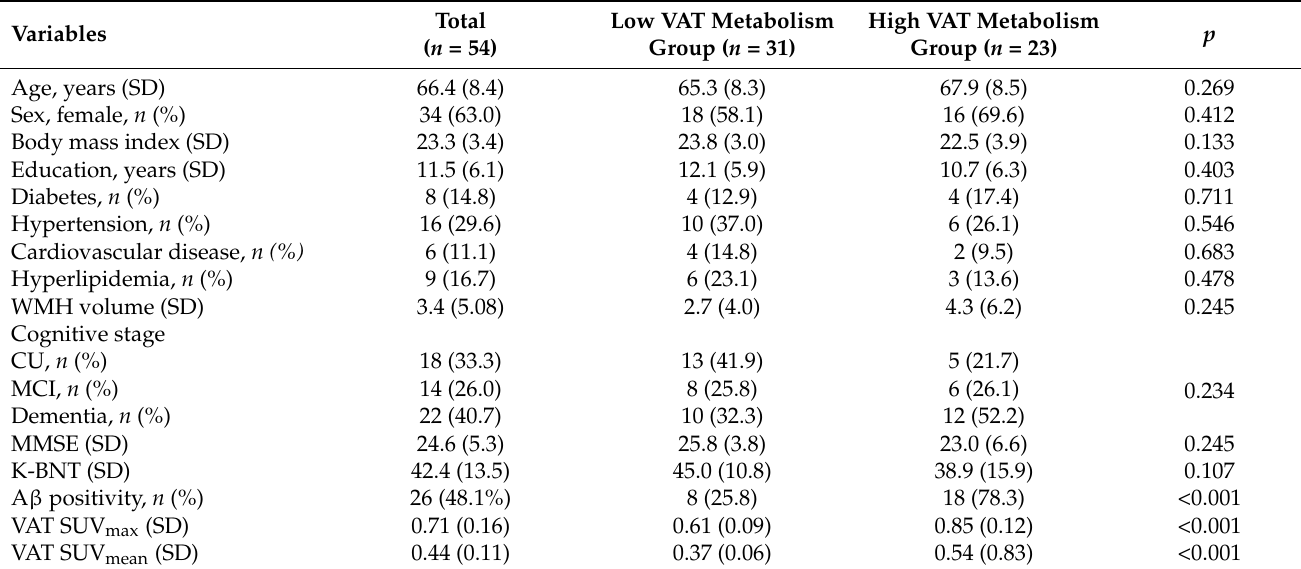
Table 2. Comparison of clinical variables between low and high VAT metabolism